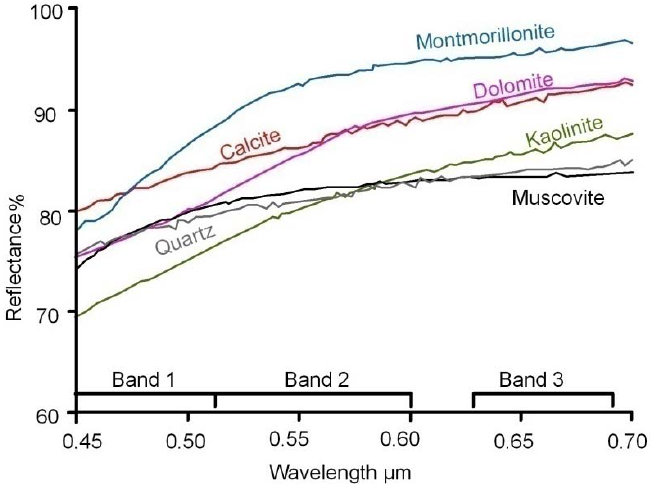
Figure 8. Spectral bands recorded by US Geological Survey. Spectral reflectance curves are given for calcite, dolomite, muscovite, montmorillonite, kaolinite and quartz